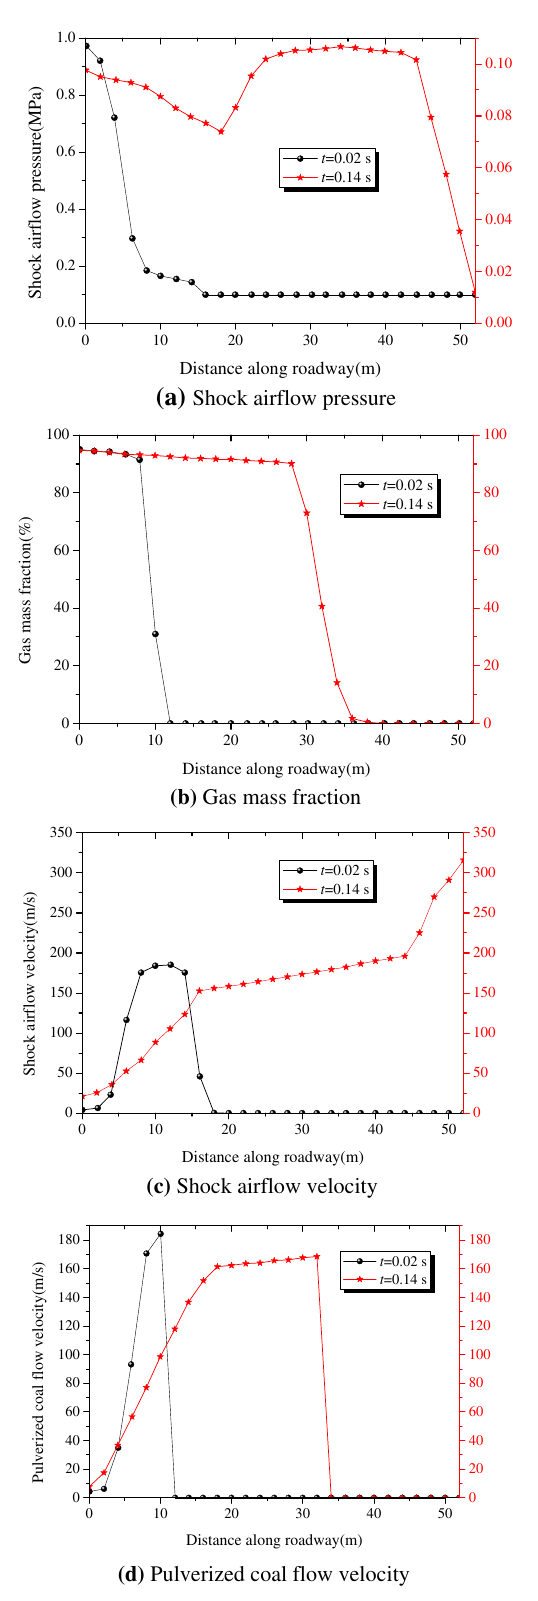
Fig. 3 Shock wave and coal–gas flow propagation in a straight roadway at different times following the outburst